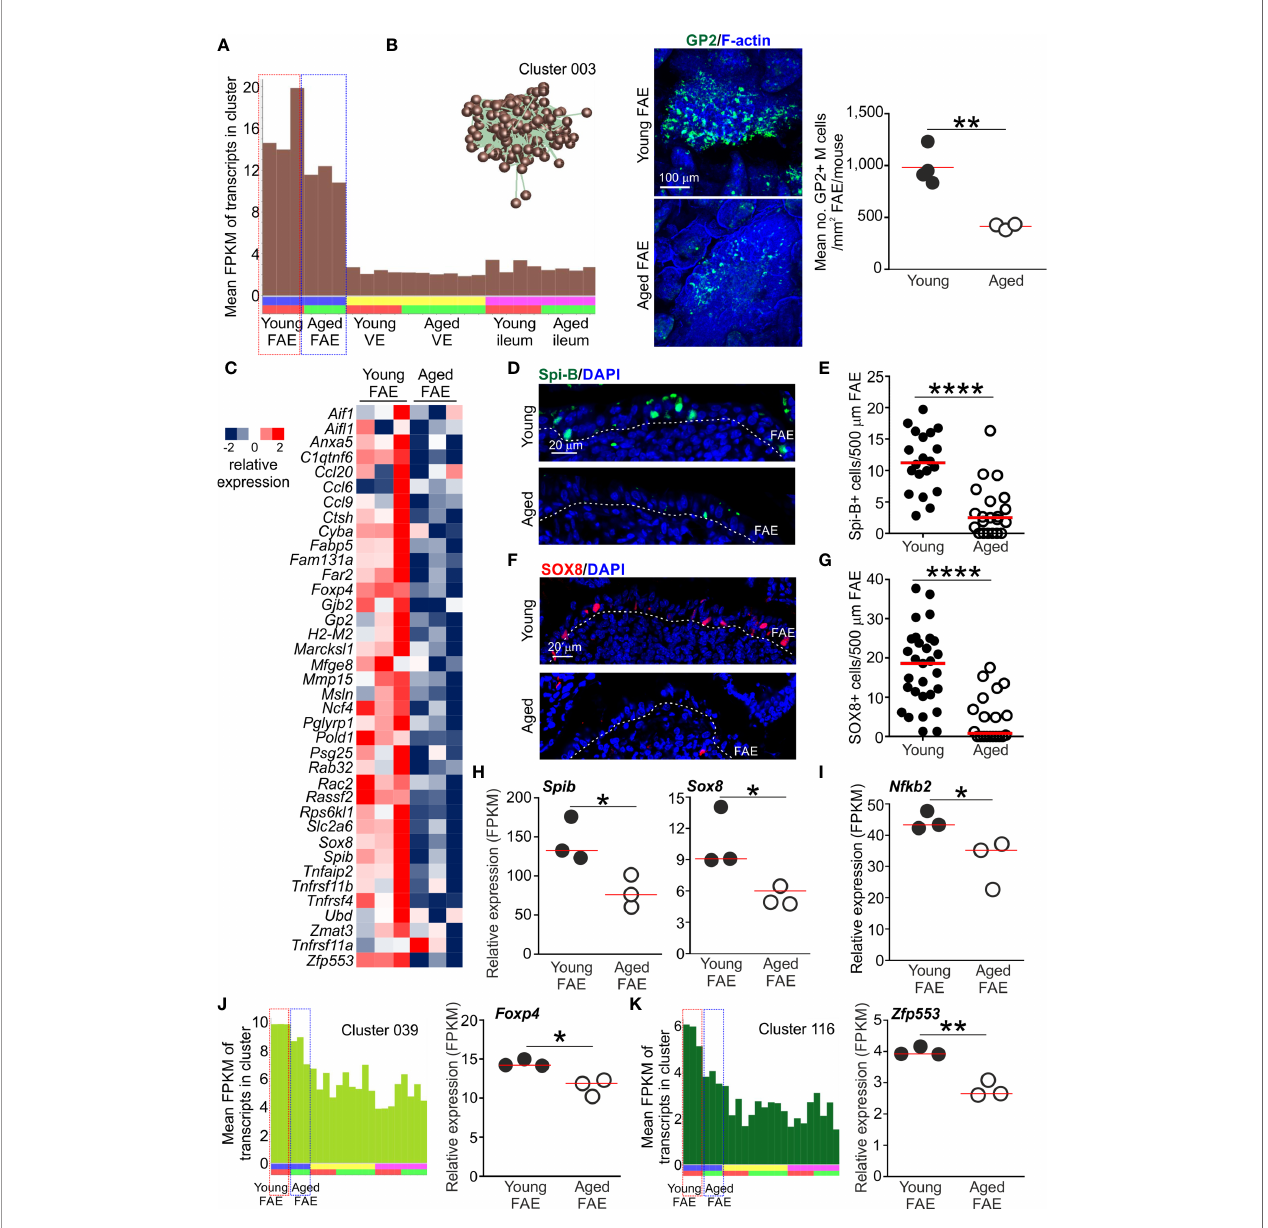
FIGURE 3 | Reduced expression of FAE- and M cell-related genes in the Peyer ’ s patches of aged mice. (A) Mean expression pro fi le (mean FPKM) of the genes in Cluster 003 across the 24 data sets. Inset shows the grouping of nodes in this cluster in the network graph shown in Figure 2B . (B) Reduced abundance of GP2+ M cells in the FAE of aged mice. Left-hand panels, whole-mount immunostaining of GP2+ M cells (green) in the FAE of young and aged mice. F-actin, blue. Right- hand panel shows mean abundance of GP2+ M cells/mouse (n=3-4/group). Horizontal bar, median. Statistical differences determined by t test. (C) Heat map shows relative expression of selected M cell-related genes in the FAE of young and aged mice. (D) IHC detection of Spi-B+ cell nuclei in the FAE of Peyer ’ s patches from young and aged mice. Cell nuclei counterstained with DAPI, blue. Dotted line, basal boundary of the FAE. (E) Comparison of frequency of Spi-B+ cell nuclei in the FAE. N=20-21 FAE/group. Horizontal bar, median. Statistical differences determined by Mann-Whitney U test. (F) IHC detection of SOX8+ cell nuclei in the FAE of Peyer ’ s patches from young and aged mice. Cell nuclei counterstained with DAPI, blue. Dotted line, basal boundary of the FAE. (G) Comparison of frequency of SOX8+ cell nuclei in the FAE. N=20-29 FAE/group. Horizontal bar, median. Statistical differences determined by Mann-Whitney U test. (H – I) Relative expression level (FPKM) of Spib , Sox8 and Nfkb2 , respectively, in individual FAE mRNA-seq data sets from young and aged mice. (J) Left-hand panel shows the mean expression pro fi le (mean FPKM) of the genes in Cluster 039 across the 24 data sets. Right-hand panel shows the relative expression level (FPKM) of Foxp4 in individual FAE mRNA-seq data sets from young and aged mice. (K) Left-hand panel shows the mean expression pro fi les (mean FPKM) of the genes in Cluster 116 across the 24 data sets. Right-hand panel shows the relative expression level (FPKM) of Zfp553 in individual FAE mRNA-seq data sets from young and aged mice. (H – K) Horizontal bars, median. Statistical differences determined by t test. *P < 0.05; **P < 0.01; ****P <